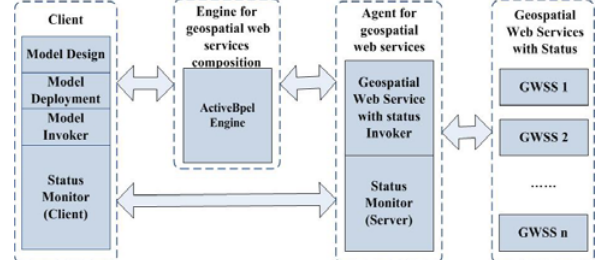
Figure 1. Framework